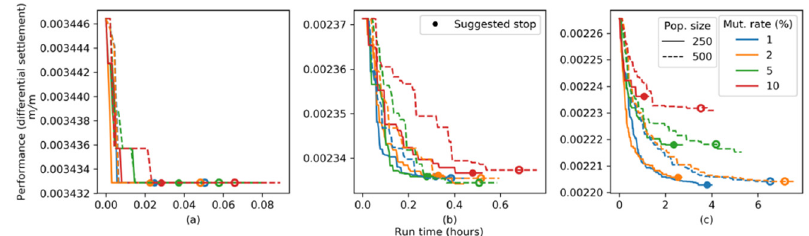
Figure 4. Evolution plots for a nine-pile, 40 × 40 m building and ( a ) 1 borehole, ( b ) 5 boreholes, and ( c ) 25 boreholes.